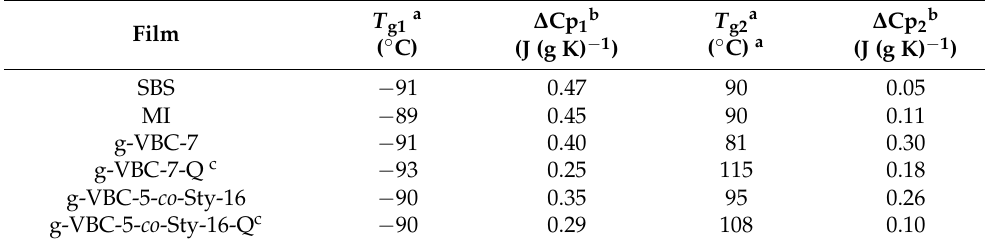
Table 3. DSC data of SBS, MI, and graft copolymers.